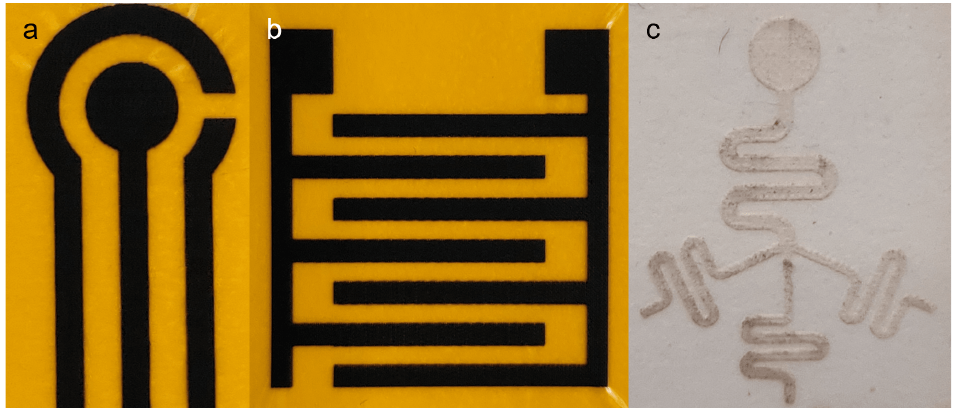
Figure 7. Photographs showing additional designs fabricated by the protocol presented. ( a ) LIG designed after commercial screen-printed electrode (SPE). ( b ) Interdigitated LIG electrode. ( c ) Microfluidic test design combining different elements, including straight and curved lines of different widths, intersection with branching multiple channels, and circular geometry in a single unit.